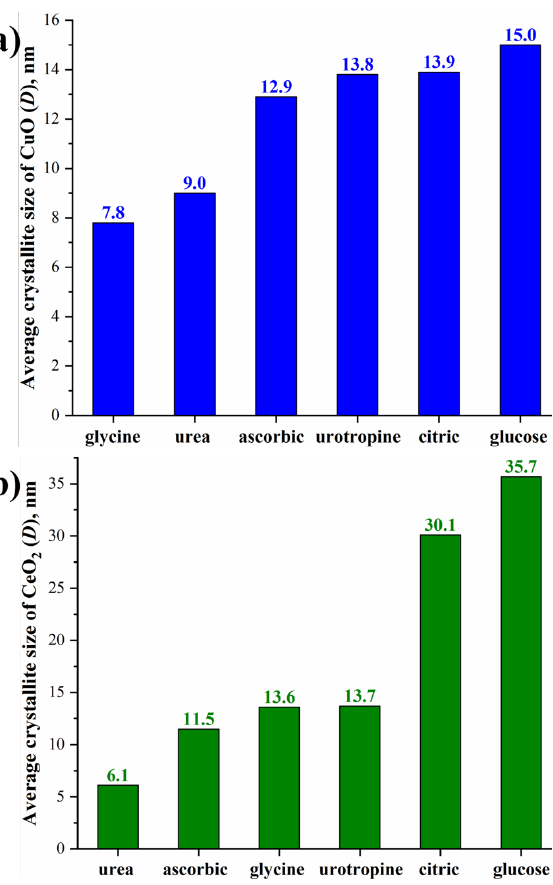
Figure 3: The average crystallite size of CuO (a) and CeO 2 (b).